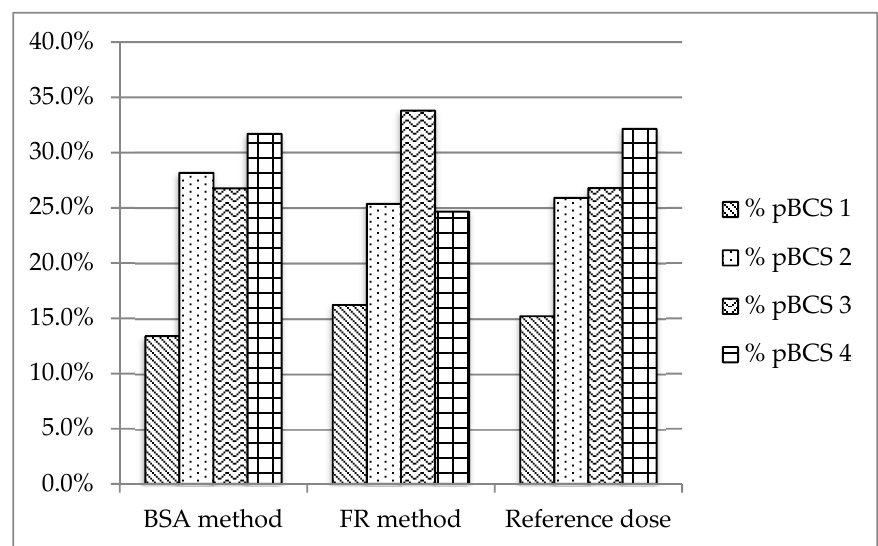
Figure 3. Distribution of provisional pBCS classification in infants (1–24 months) .